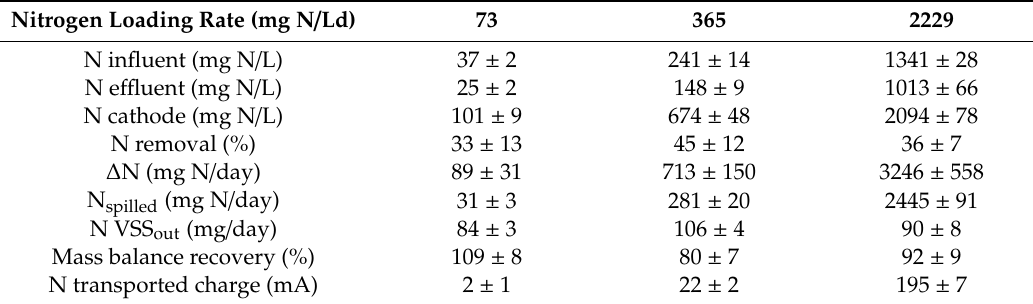
Table 2. N removal and mass balance during the three operating